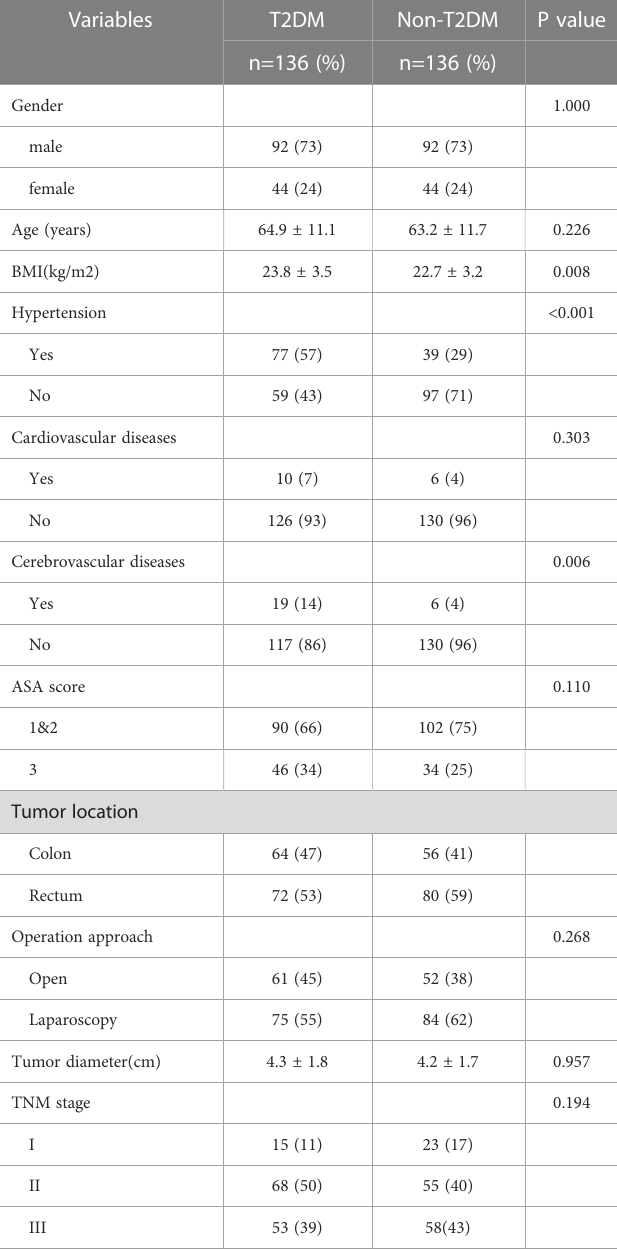
TABLE 1 The basic characteristics of the included